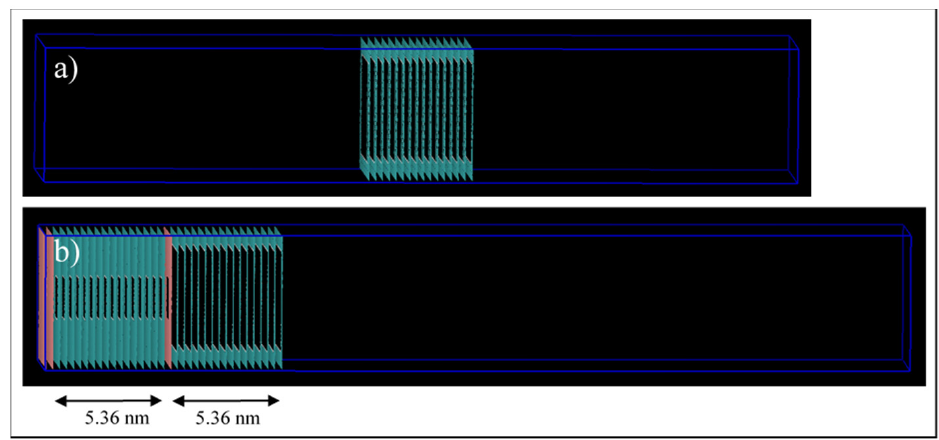
Figure 3. Simulation box for the pore models. ( a ) Single pore, and ( b ) connected 5-nm to 2-nm pores.